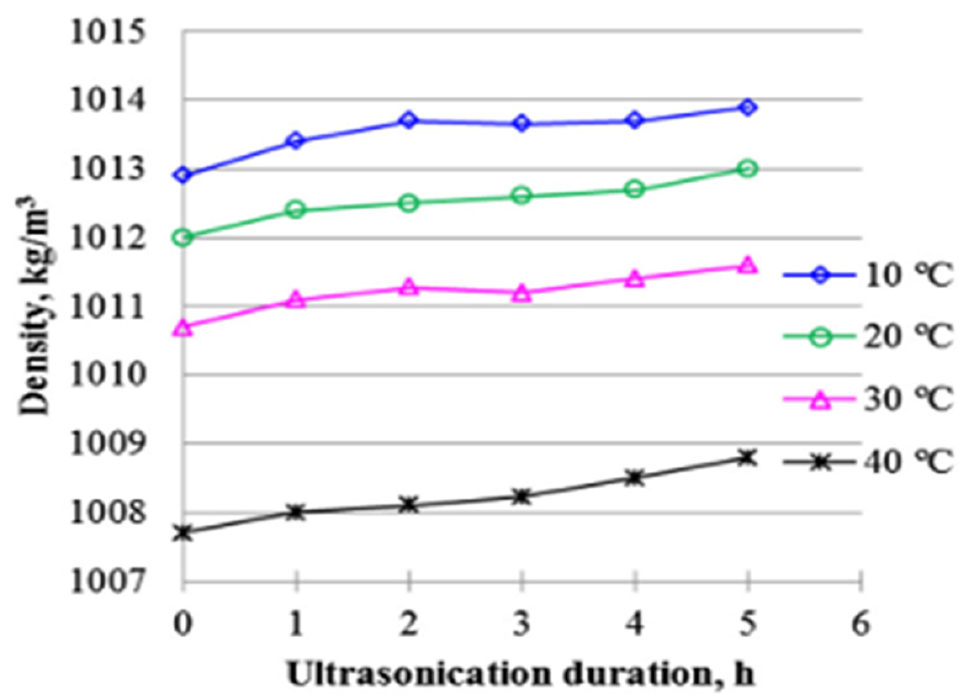
Figure 6. Influence of ultrasonication duration on density of 0.5 vol% Al 2 O 3 -water NF at different temperatures. Adapted from [150].